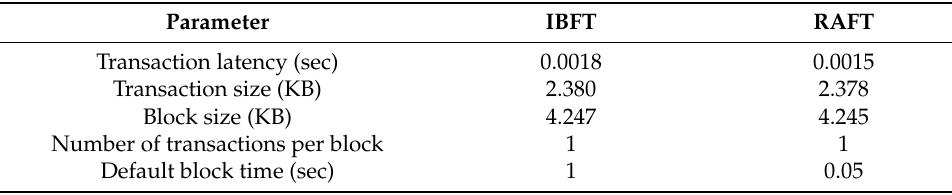
Table 6. Time and space complexity of a transaction and block.